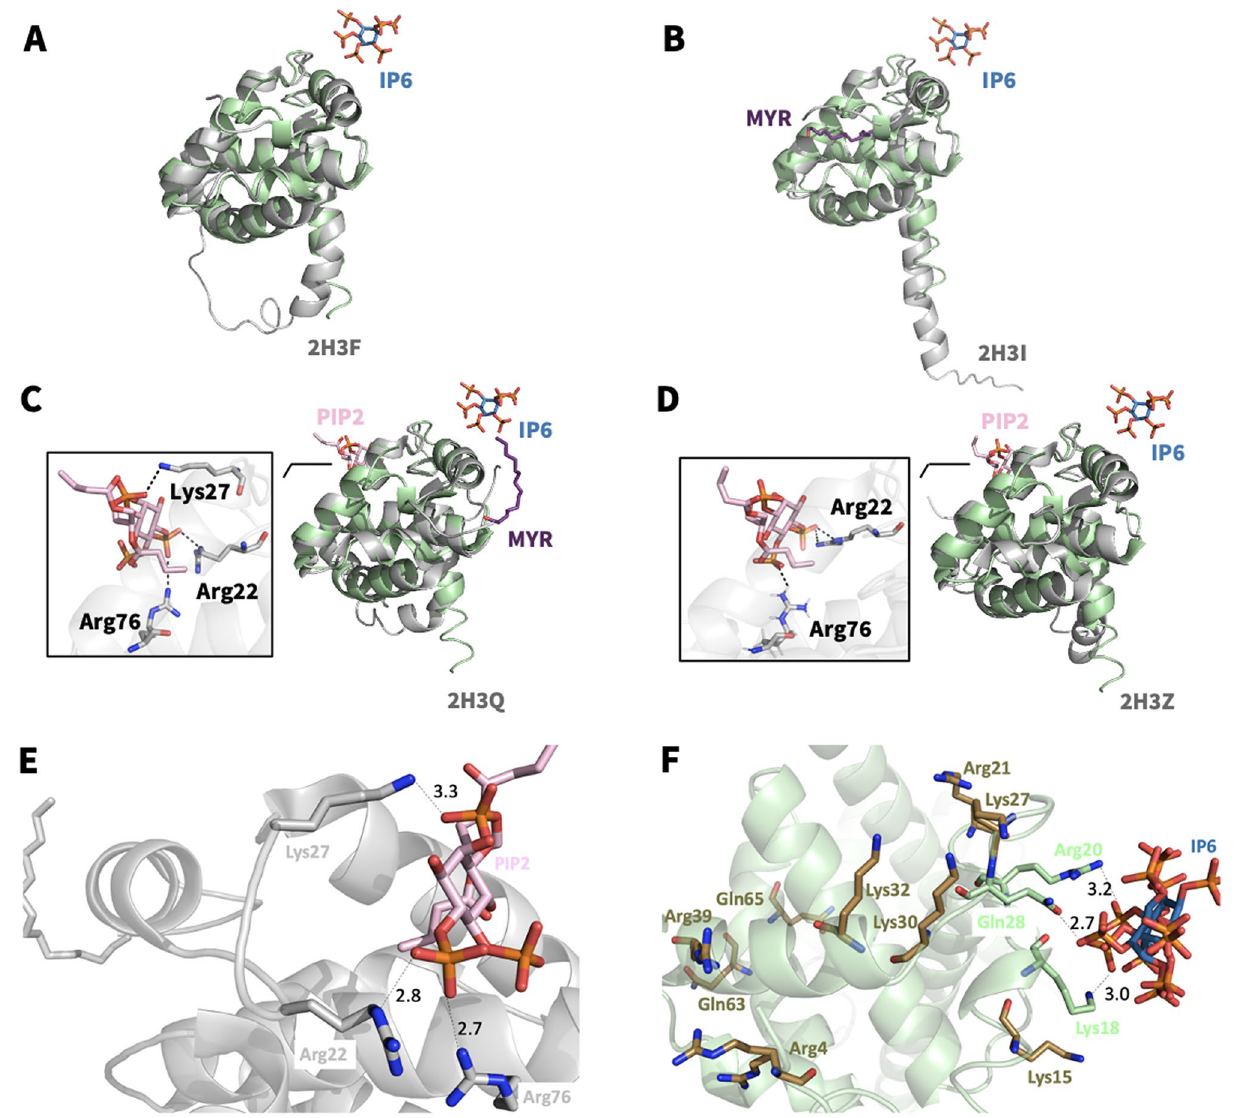
Figure 5. Structural comparison of MA_IP6_C2 with other MA complexes. Chain A of MA_IP6_C2 complex in green is superposed ( a ) with MA structure in gray (PDB ID: 2H3F), RMSD of 0.864 Å; ( b ) with MA structure that has myristoylation (purple) in gray (PDB ID: 2H3I), RMSD of 0.737 Å; ( c ) with MA structure that has myristoylation (purple) and PIP2 in gray (PDB ID: 2H3Q), RMSD of 0.742 Å; ( d ) with MA structure that has PIP2 in gray (PDB ID: 2H3Z), RMSD of 0.818 Å. The interaction between ( e ) IP6 and MA domain, ( f ) PIP2 and MA domain (PDB ID:2H3Q) is represented in more detail to equate the position of the corresponding molecules and angles more clearly. PIP2 is shown in color ‘light pink’, IP6 is shown in ‘sky-blue’, bound residues in ‘deep-olive’, rest of the highly basic region in ‘forest’, rest of the domain in ‘Gray’. Also, Lys27, Lys30, Lys32 and Arg39, Gln63 and Gln65 are shown to specify the regions mutated in DSF studies regarding the melting temperature. O is coded with red color, N with blue and P with orange. This figure shows that both PIP2 and IP6 bind to the MA domain within the highly basic region, however, the residues are different. Distances (within hydrogen bond boundaries) are also shown here in Angstrom. For IP6 binding, only the shortest distance between Gln28 and the IP6 is shown among 3 for